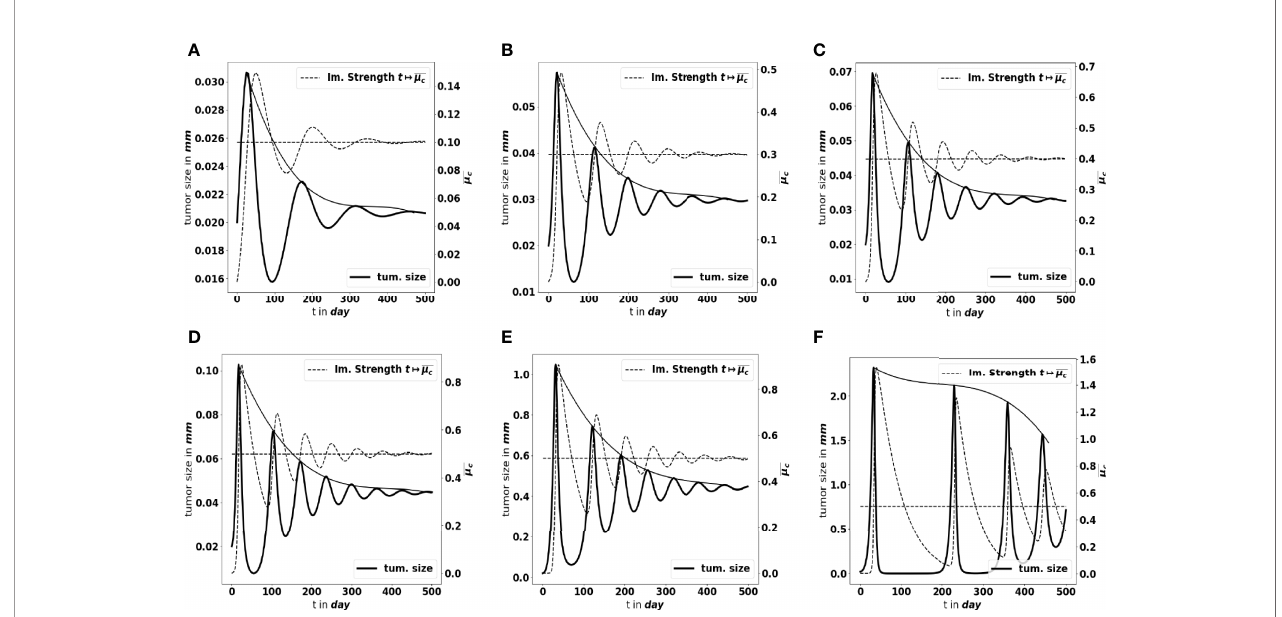
FIGURE 7 | Large-time simulation of the PDE system: evolution of the tumor diameter (bold black line, left axis), and of the concentration of immune cells (cid:1) m c (dotted grey line, right axis), for several values of the division rate a : (A) a = 0.1 day -1 , (B) a = 0.3 day -1 , (C) a = 0.4 day -1 and for several values of the immune strength A : (D) A = 1 cell − 1 c · day − 1 , (E) A = 1 · 10 − 3 cell − 1 c · day − 1 , (F) A = 1 · 10 − 5 cell − 1 c · day − 1 . The horizontal dotted line represents the predicted asymptotic value for (cid:1) m c . The solid line gives the envelope of the oscillations, indicating a polynomial damping rate. The equilibrium needs more time to establish as the strength of the immune system